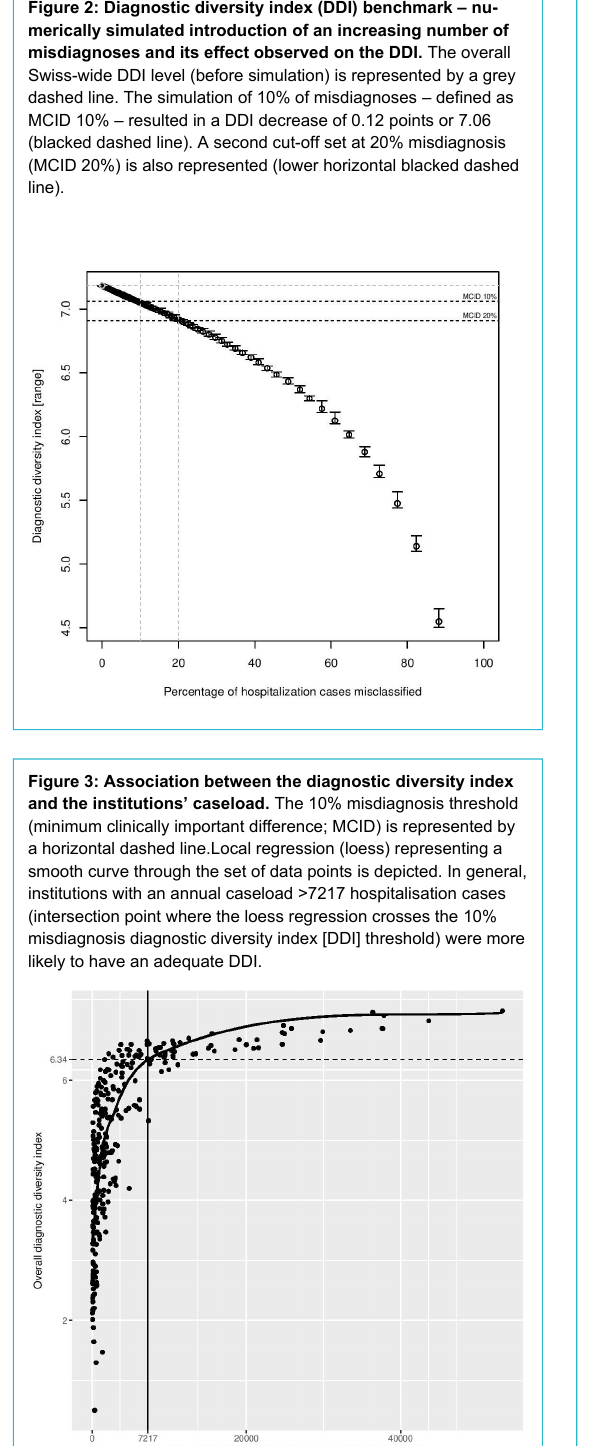
Figure 4: Heat map of the diagnostic fitness (DDI) of acute medical care hospitals within 14 ICD-10-GM chapters (A–N). For each chapter the 10% (minimum clinically important difference; MCID) and 20% misdiagnosis thresholds were established by sim- ulation. In the case of a DDI >10% and >20% threshold the re- spective bar is shown in dark and light grey for each chapter for each of the hospitals. The number of hospitalisation cases per in- stitution is coded in different bullet sizes on the right side (bigger indicating a larger caseload). This view allows four groups of acute medical care hospitals to be distinguished (see